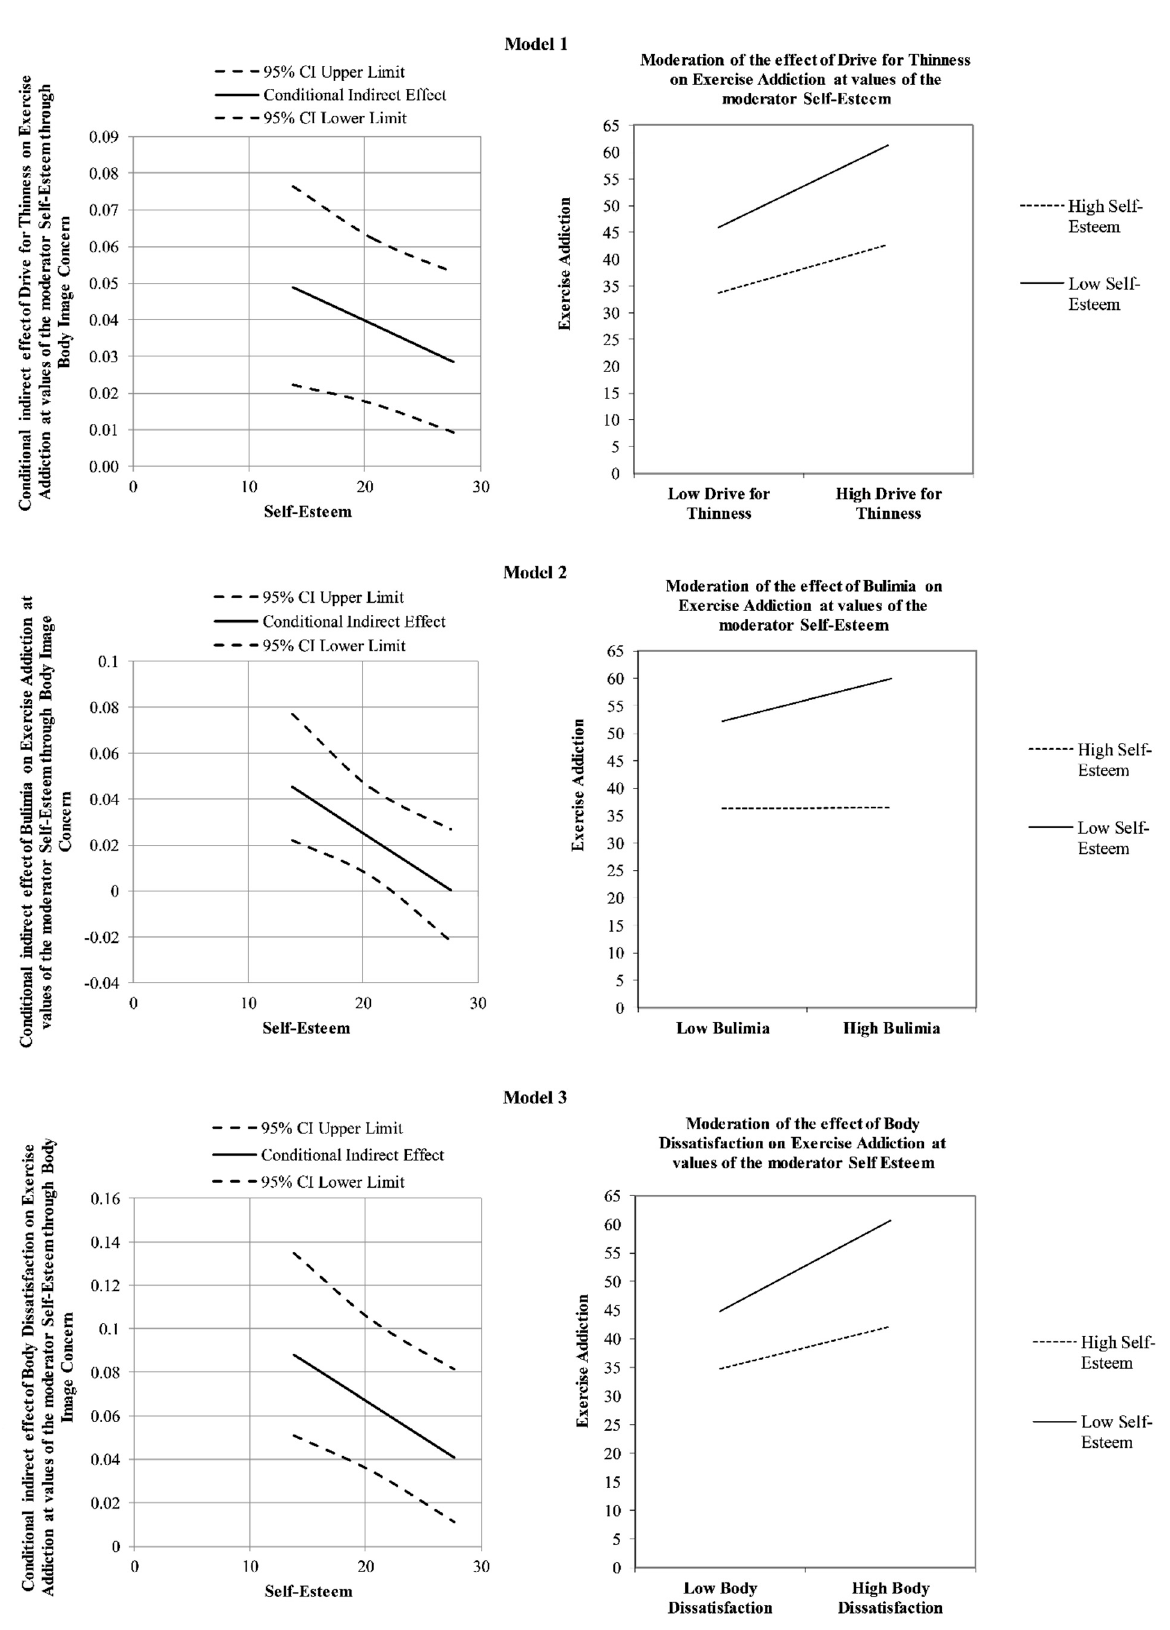
Figure 4. Graphic representation of the moderation effect for each Model.